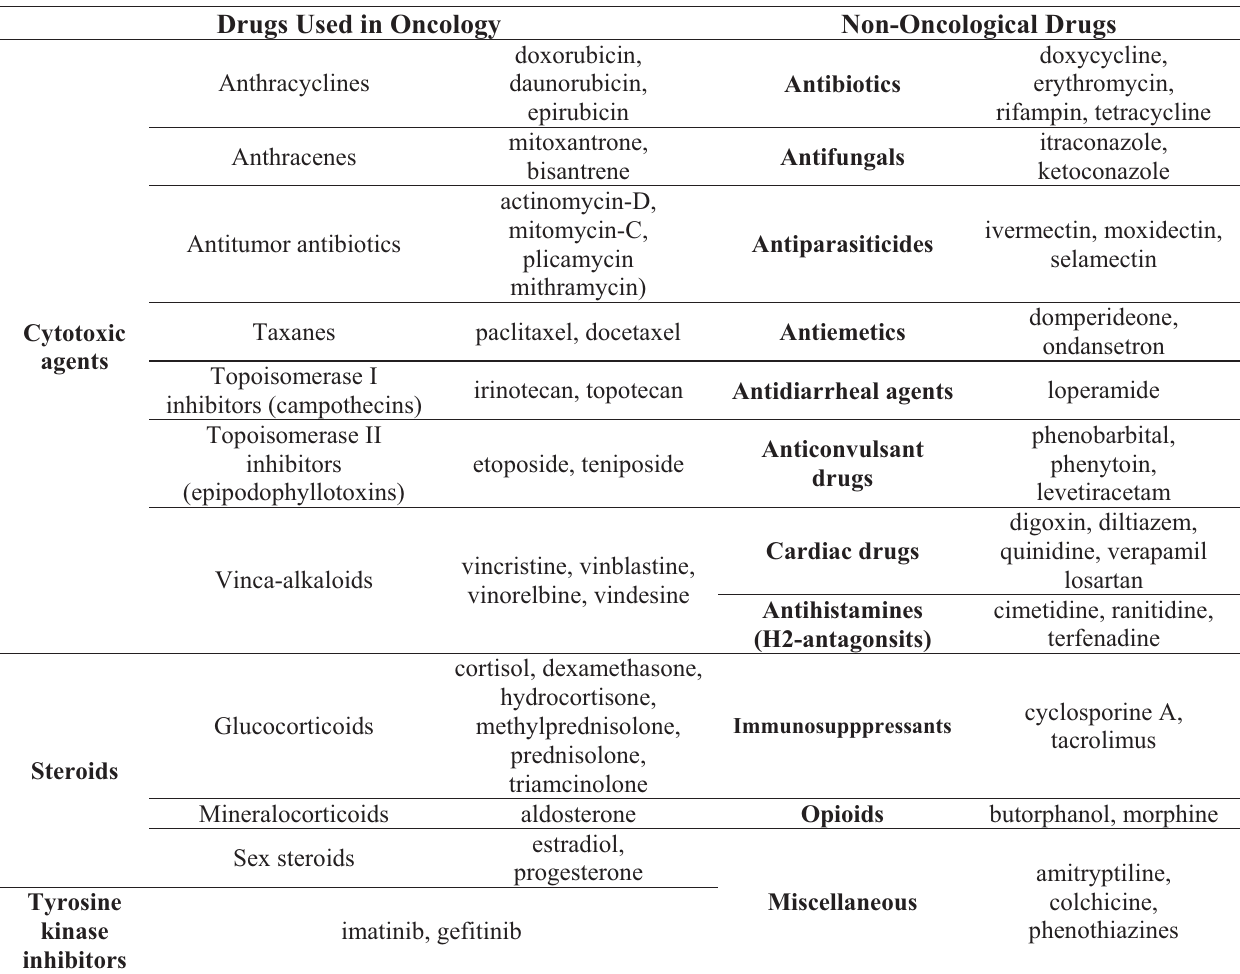
Table 4. A selection of clinically relevant drugs and compounds that are known P-gp substrates